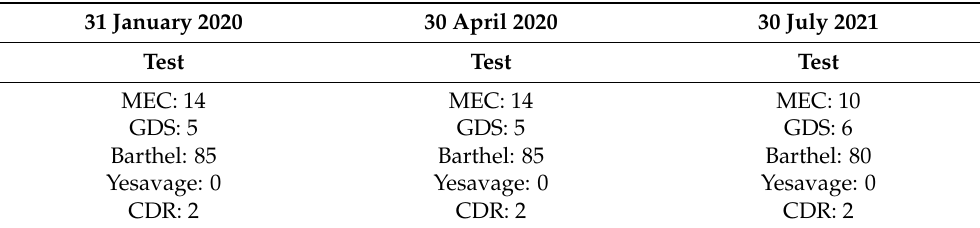
Table 2. Follow-up in the results of the MEC, GDS, Barthel, Yesavage, and CDR